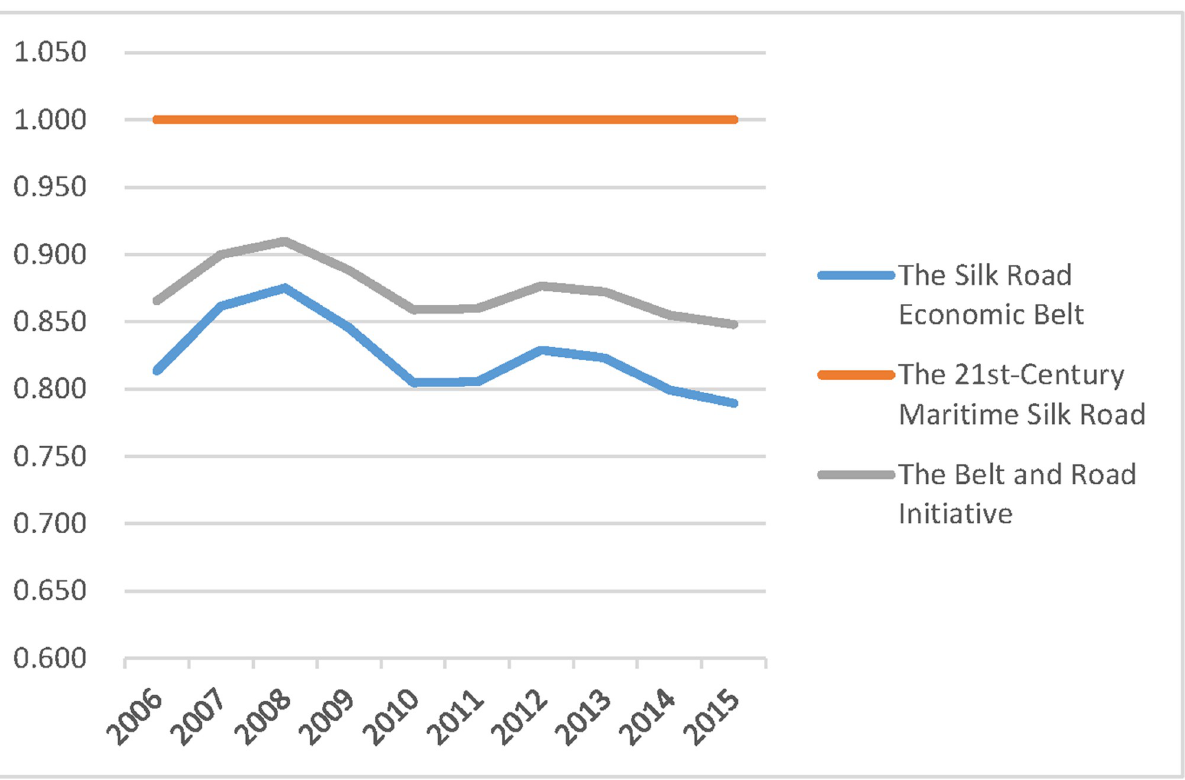
Fig 2. Pure technical efficiency of different regions, 2006–2015.